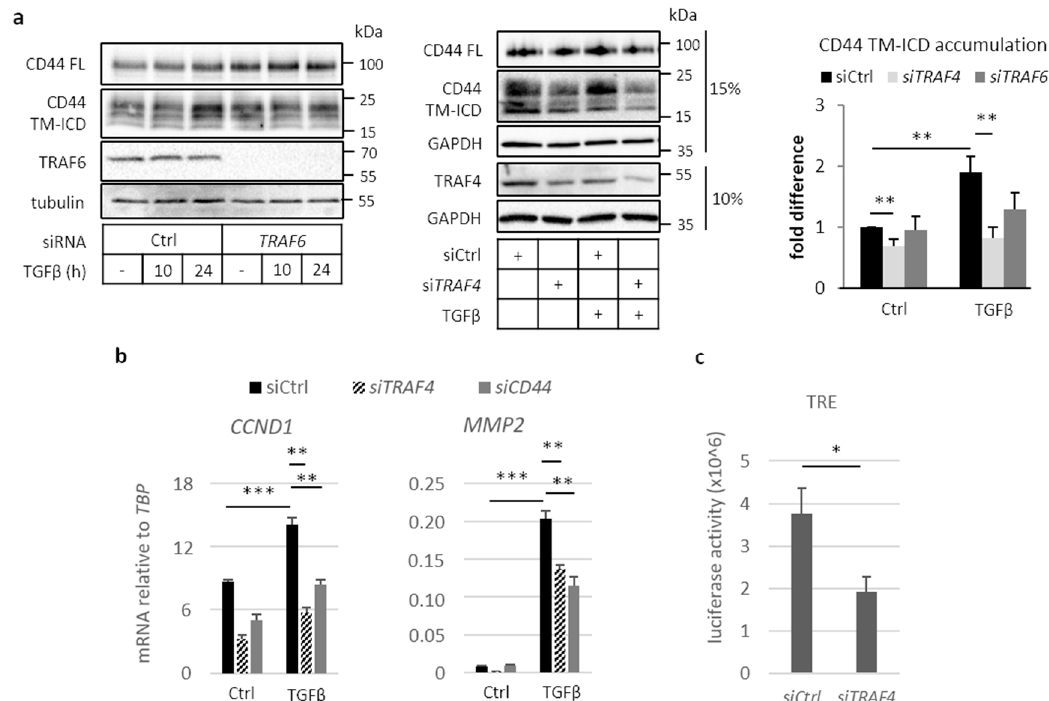
Figure 3. Tumor necrosis factor receptor associated factor (TRAF) family members mediate TGF β -induced CD44 cleavage. ( a ) A549 cells were transfected with non-targeting siRNA (siCtrl) or siRNAs against TRAF6 or TRAF4 , and stimulated or not with TGF β for up to 24 h, followed by immunoblotting for CD44 FL, TM-ICD, TRAF6, and TRAF4; tubulin and GAPDH served as loading controls. CD44 TM-ICD bands were quantified using the ImageJ software and normalized to either tubulin or GAPDH; values are depicted as fold difference; lysates were run at either 10% or 15% polyacrylamide gels, as depicted. ( b ), A549 cells were transfected with control siRNA or siRNAs targeting TRAF4 or CD44 , and subsequently treated or not with TGF β (5 ng/mL) for 24 h. Relative mRNA levels of CCND1 and MMP2 were quantified by real-time qPCR and normalized to TBP . ( c ), A549 cells were co-transfected with scrambled control siRNA or siRNAs against TRAF4 , a β -gal reporter, and a TPA-responsive element (TRE) luciferase reporter, after which luciferase activity was measured and normalized to β -gal activity. All graph bars are shown as the average ± standard error of the mean (SEM), based on at least three independent experiments, unless mentioned otherwise. Asterisks illustrate significant differences between the conditions indicated with lines; * p < 0.05, ** p < 0.01, *** p < 0.001.